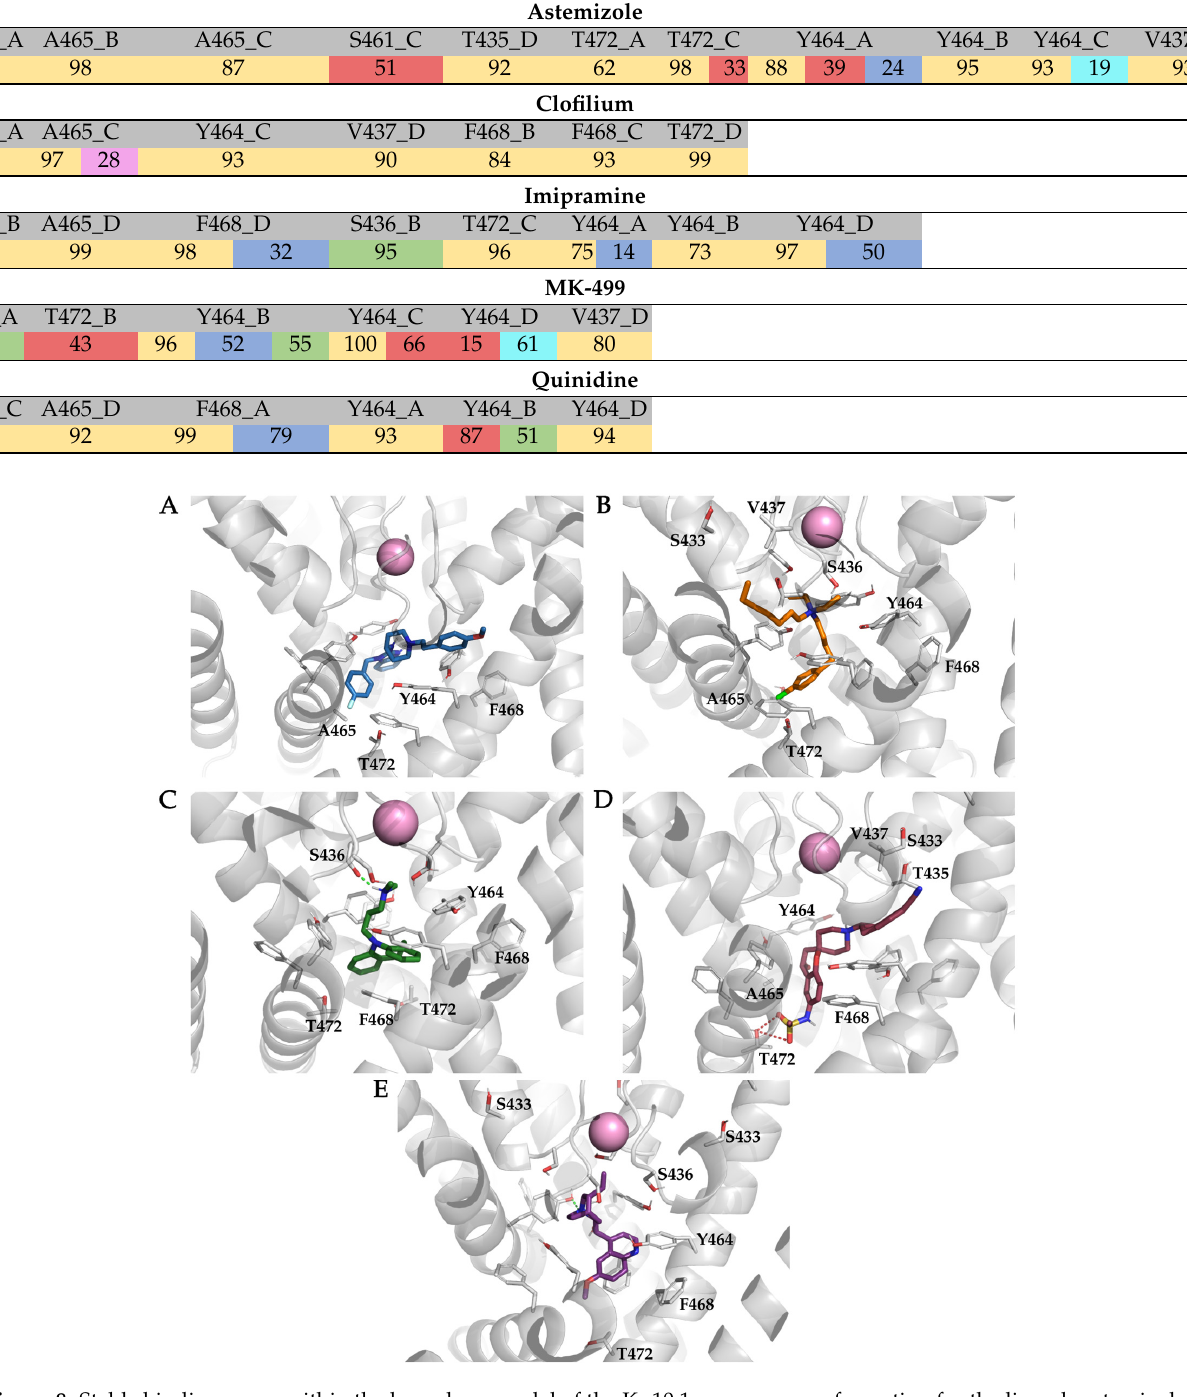
Table 3. Relative occurrences (%) of interactions with different residues in the K V 10.1 binding site during the MD simulations for astemizole, clofilium, imipramine, MK-499, and quinidine (as indicated). Residues are labeled as A–D according to the subunits of K V 10.1. The cells are colored according to the pharmacophore features: blue, aromatic; yellow, hydrophobic; red, hydrogen bond acceptor; green, hydrogen bond donor; cyan, positive ionizable; pink, halogen bond donor.